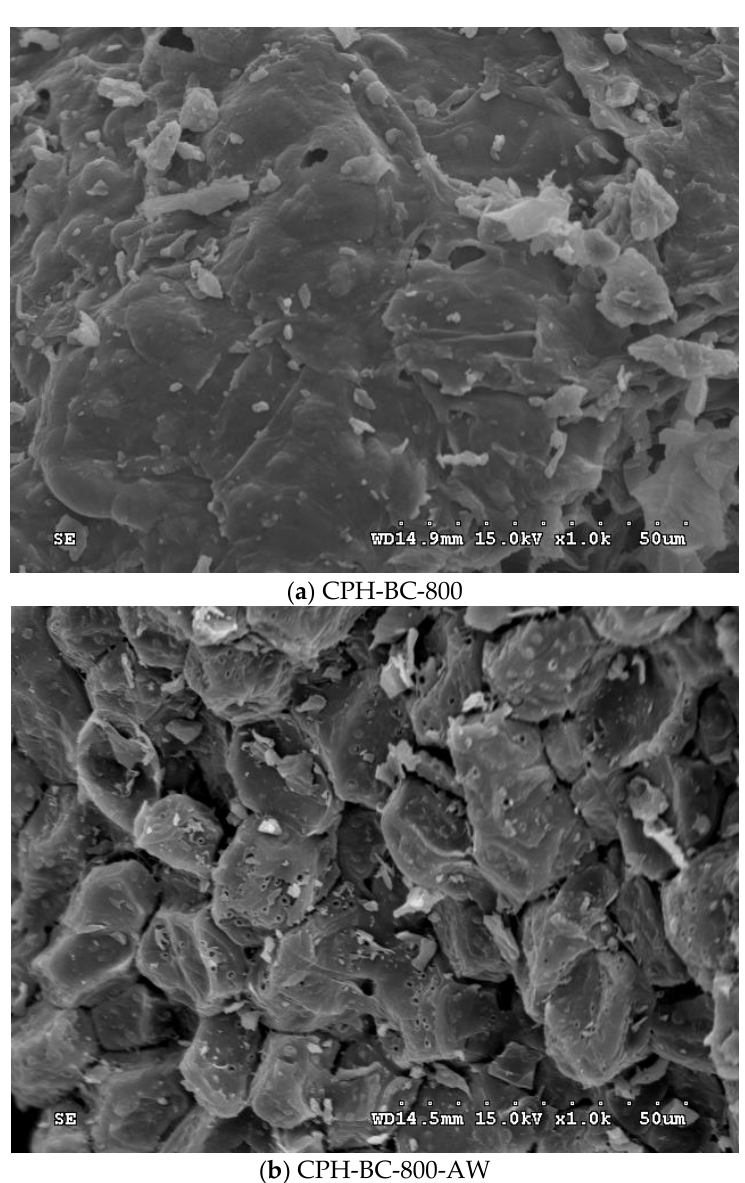
Figure 3. SEM images (×1000) of ( a ) CPH-BC-800, ( b ) CPH-BC-800-AW.